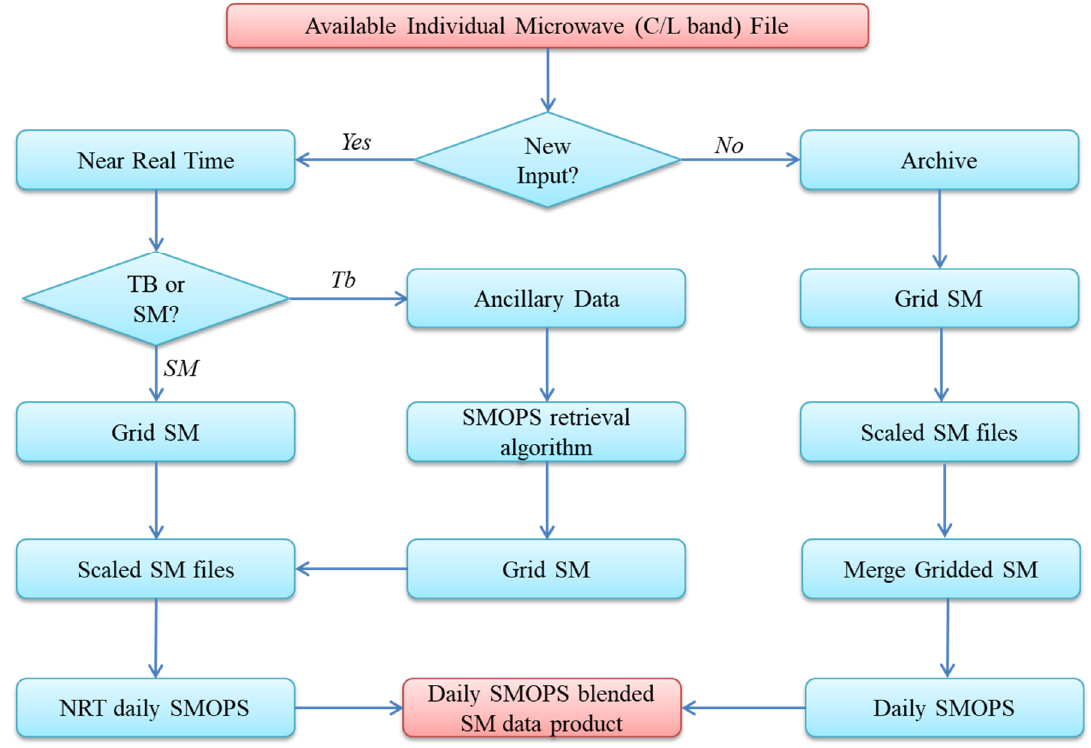
Figure 2. Processing flow of the daily SMOPS blended soil moisture data product. The abbreviations SM and Tb indicate soil moisture and brightness temperature.